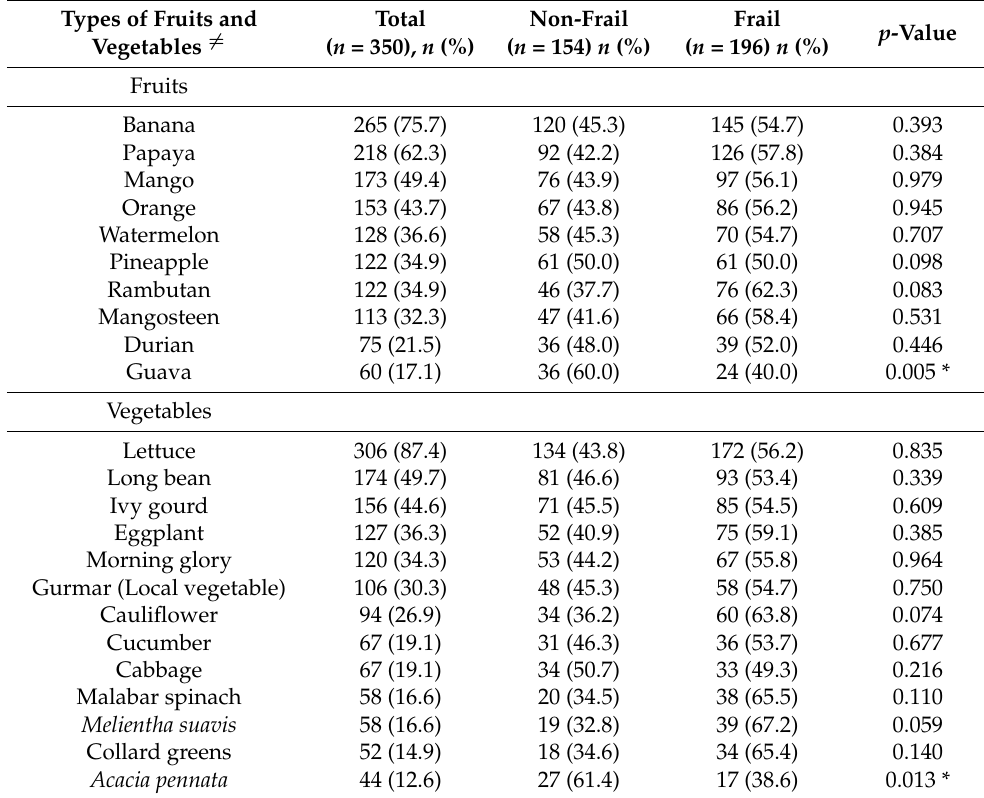
Table 3. Comparison of fruits and vegetables consumption in non-frail and frail older adults.